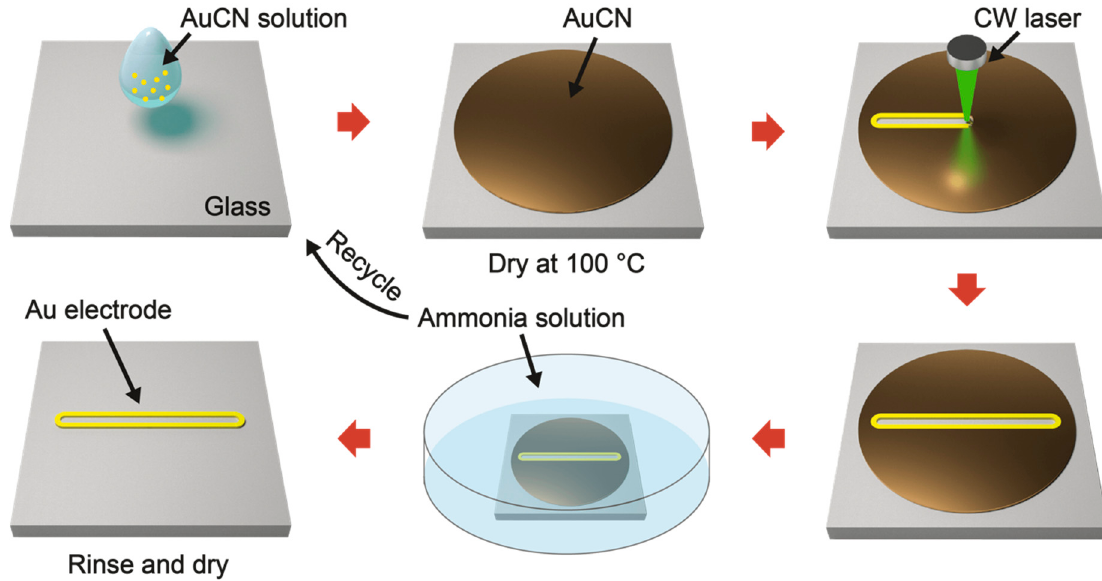
Figure 1. Schematic drawing of a transformative gold patterning through selective laser refining of cyanide: AuCN dissolved in ammonia solution is drop-casted and dried on the glass substrate. After the laser processing, the residual AuCN is rinsed, and the Au electrode is selectively fabricated as a resultant.